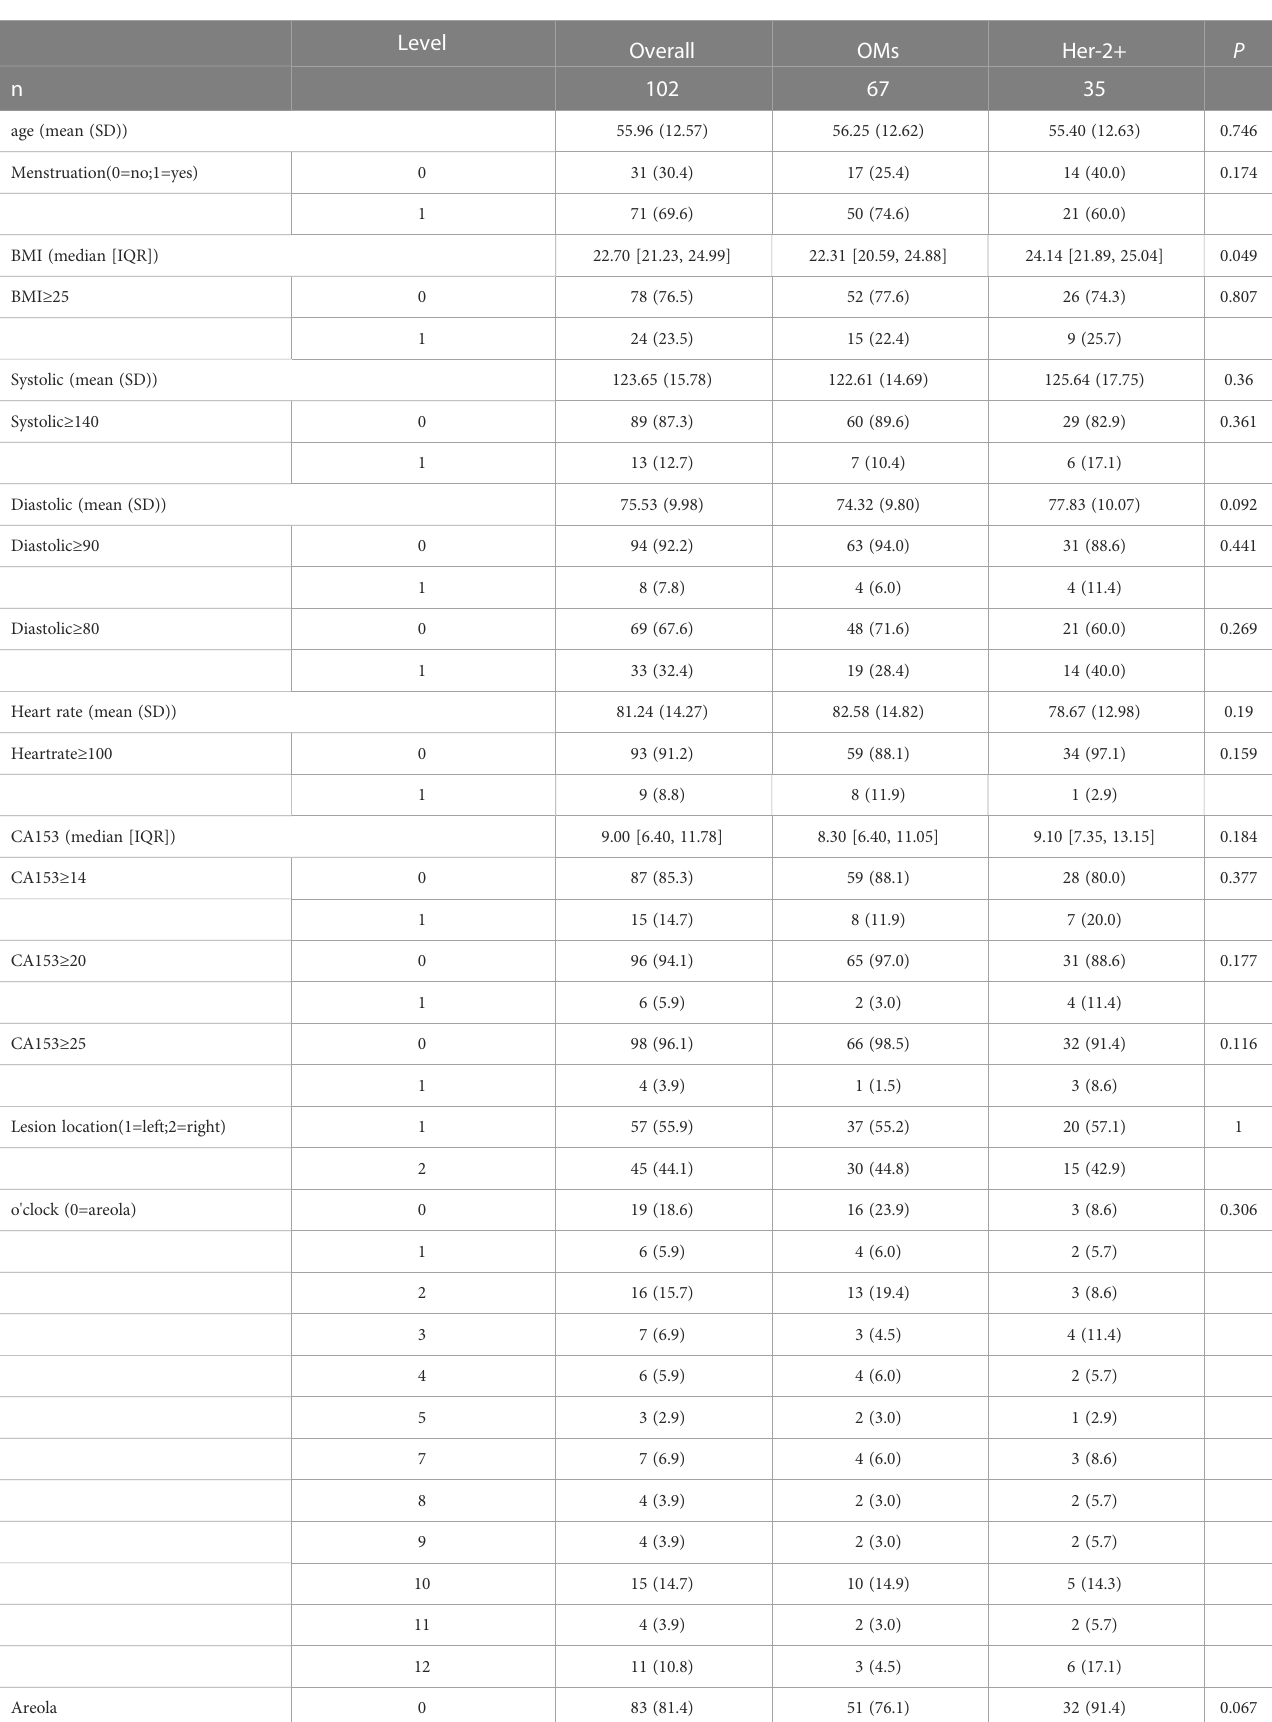
TABLE 1 Univariate analysis of Clinical, US and CEUS features for predicting Her-2 overexpressing in training cohort.